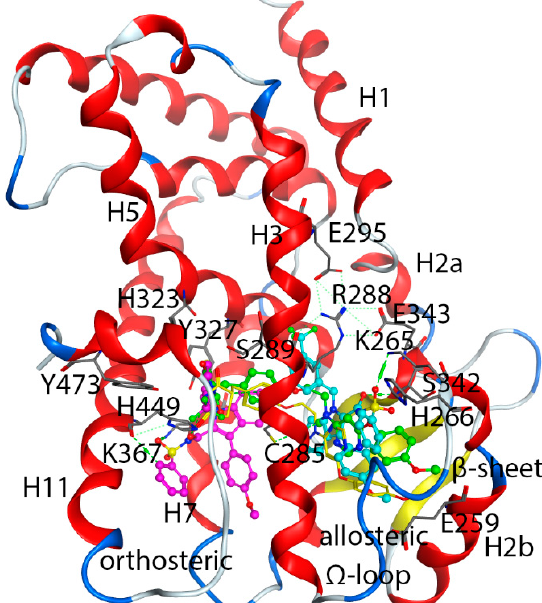
Figure 1. Co-crystal structure of NSI-bound PPAR γ (PDB id: 2HFP). Among two bound ligands (PDB ligand ID: NSI), one binds to the orthosteric pocket (magenta NSI) and the other to the allosteric site (cyan NSI). Lobeglitazone of native bound structure (PDB id: 5Y2T), yellow; Lobeglitazone from the docked pose of this study, green. Some helices and interacting residues for the orthosteric and allosteric bindings were labeled. Residues were presented as one letter code for clarity.